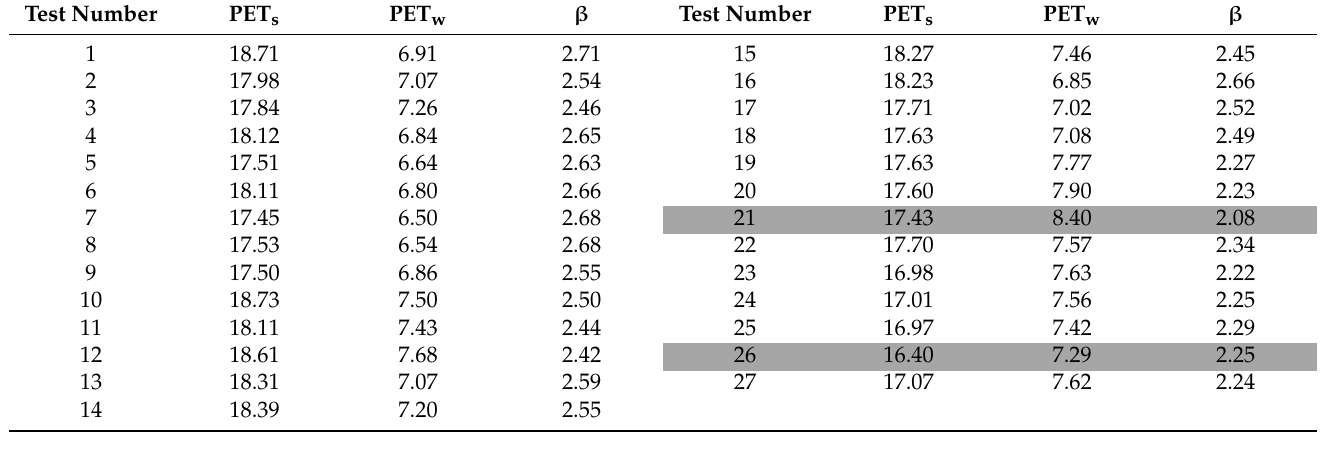
Table 11. Optimization calculation results for summer and winter.